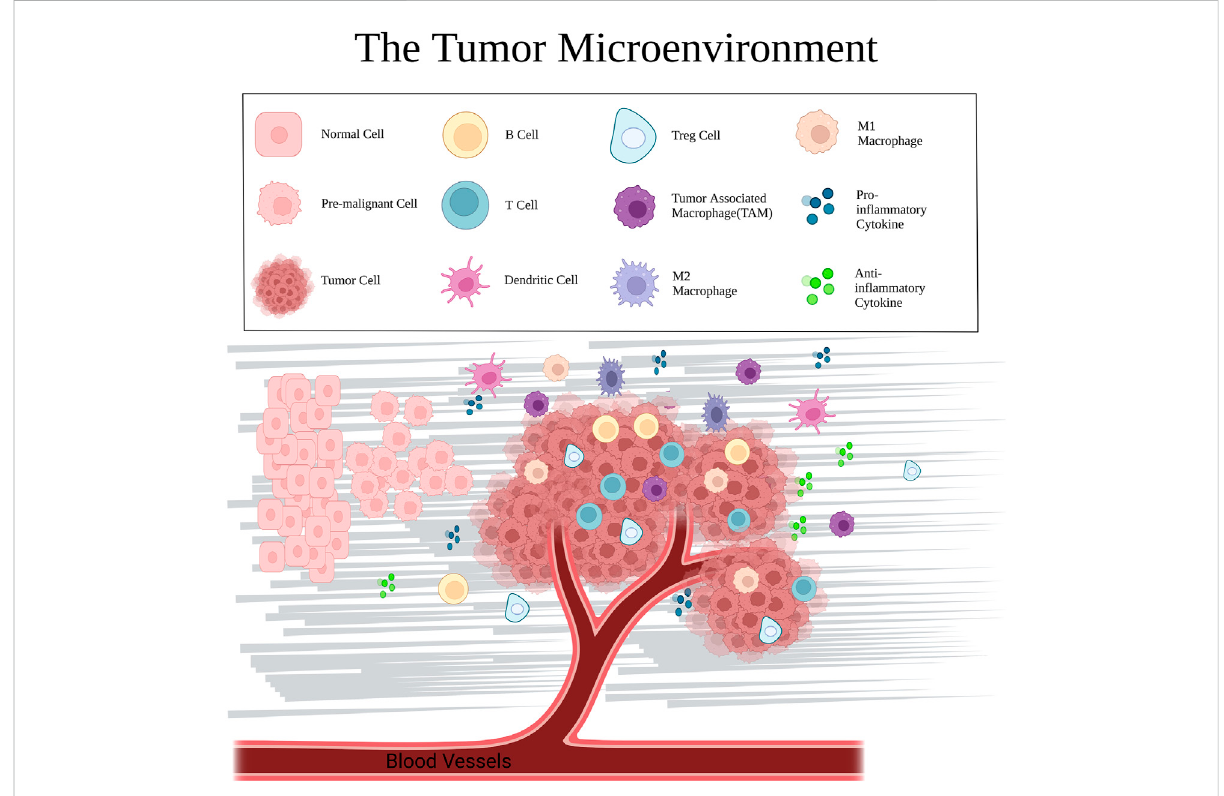
FIGURE 2 Major cellular components and mediators in the TME, including normal cells, cancer cells, immune cells (T cells, B cells, dendritic cells, TAMs, and macrophages), cytokines, and extracellular